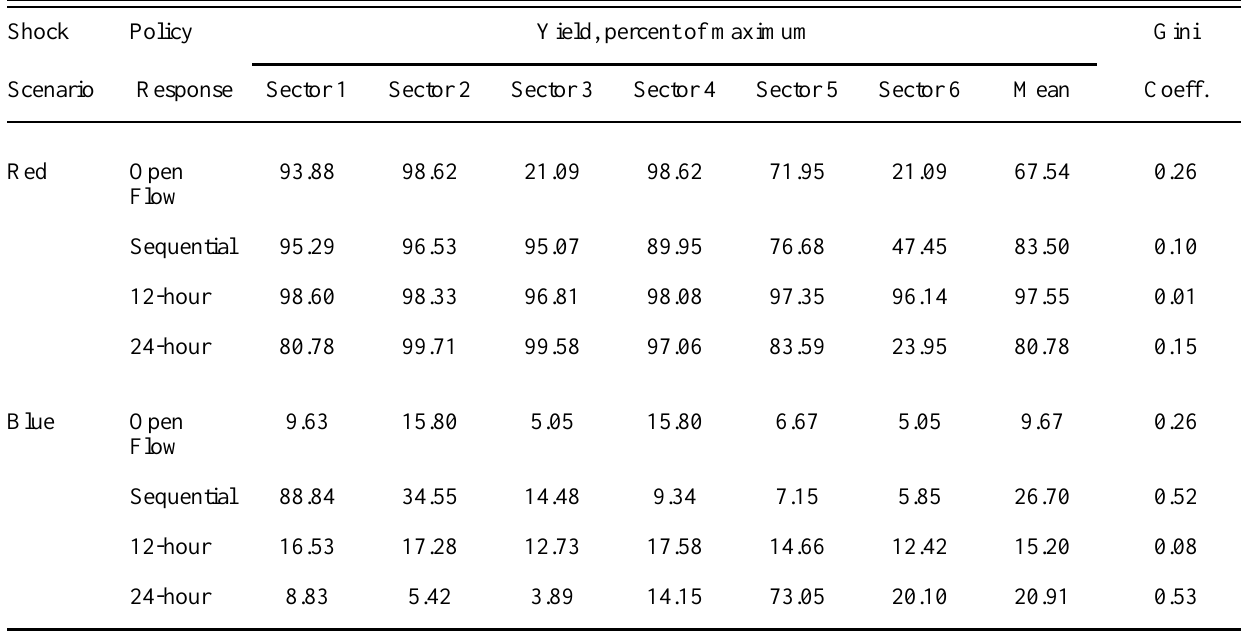
Table 2 . Comparison of policy performance given a serious shock to headwork infrastructure (i.e. headworks completely washed out due to extrememly high river discharge) in the midseason.